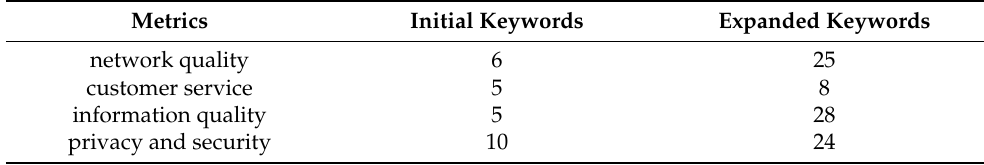
Table 5. The results of the expanded